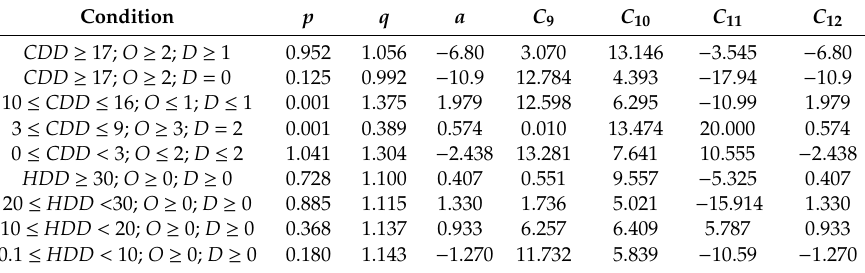
Table 3. Coe ffi cients of Equation (3) determined by the PSO